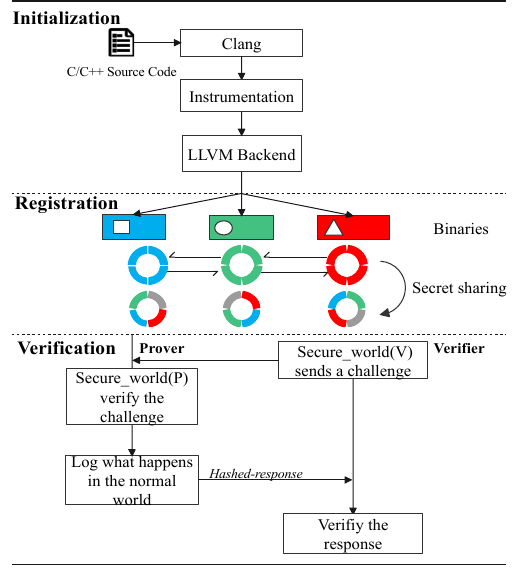
Figure 10. Relationship among components in